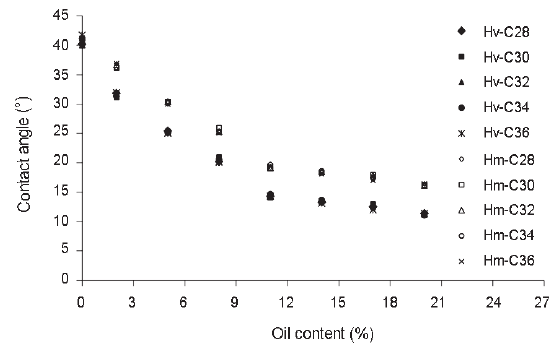
Fig. 18. Evolution of contact angle as a function of oil content